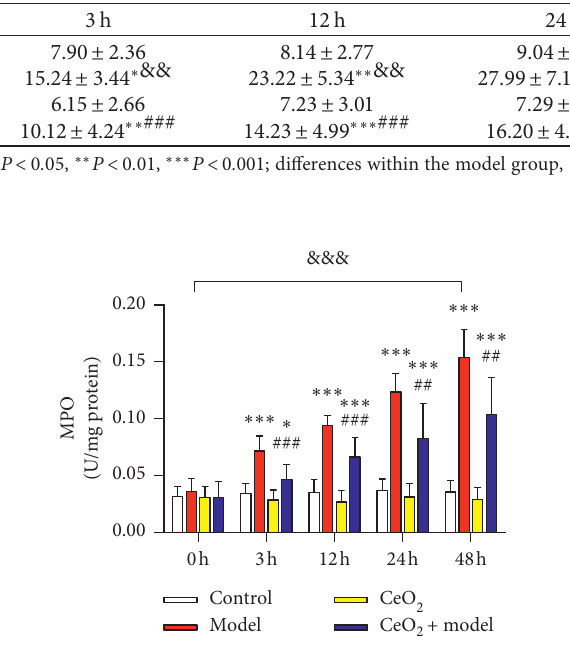
Table 3: TNF- α levels in serum of each group of rats (pg/ml).